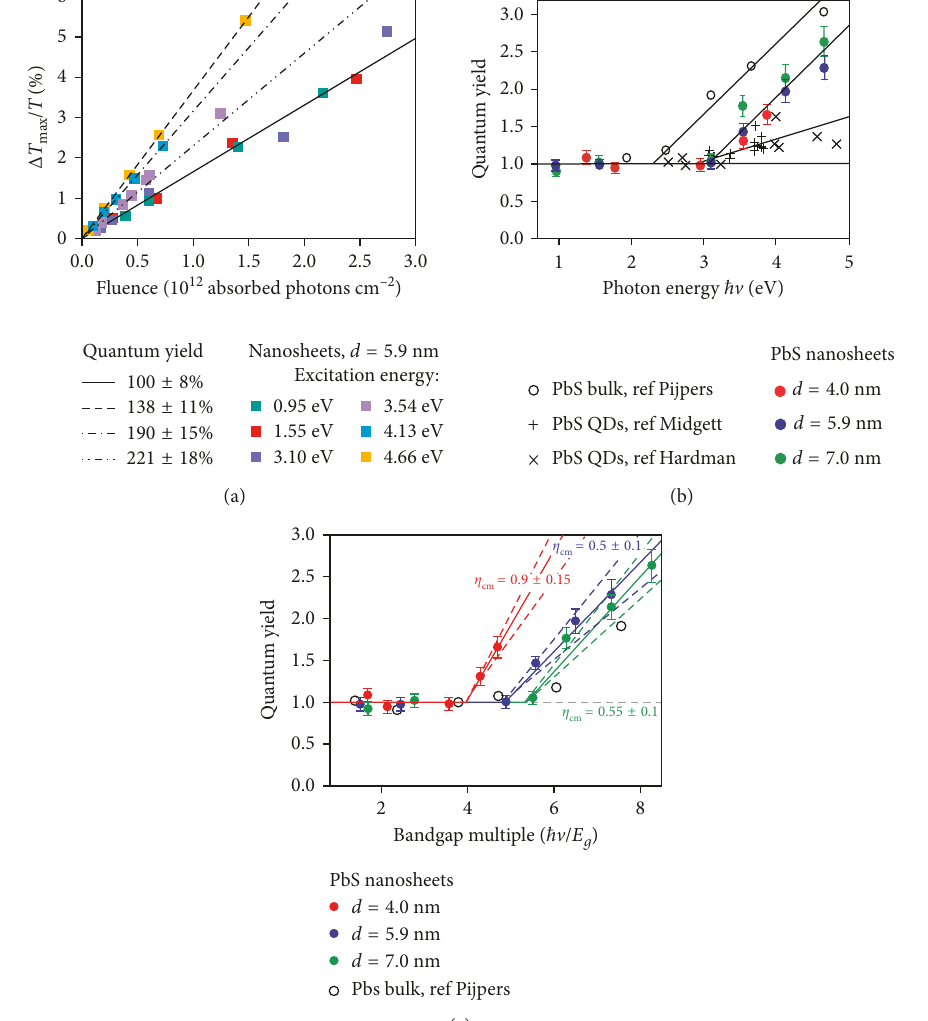
(c) Figure 8: (a) Maximum bleach signal obtained from transient absorption, against pump photon energies for PbS nanosheets of 5.9nm thickness. The solid line implies QY 1, and the steeper lines imply higher QYs. (b and c) Quantum yield against pump photon energy (cid:29) /E standardised pump photon energies g . Slope of data in the middle and right figures is equal to η . Figures adapted from ℏω